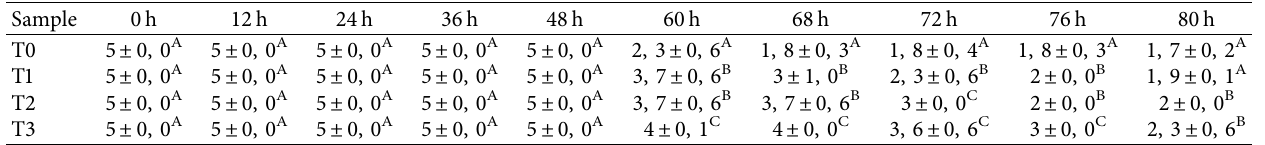
Table 4: The color of meatballs coated with smoke powder of various pyrolysis